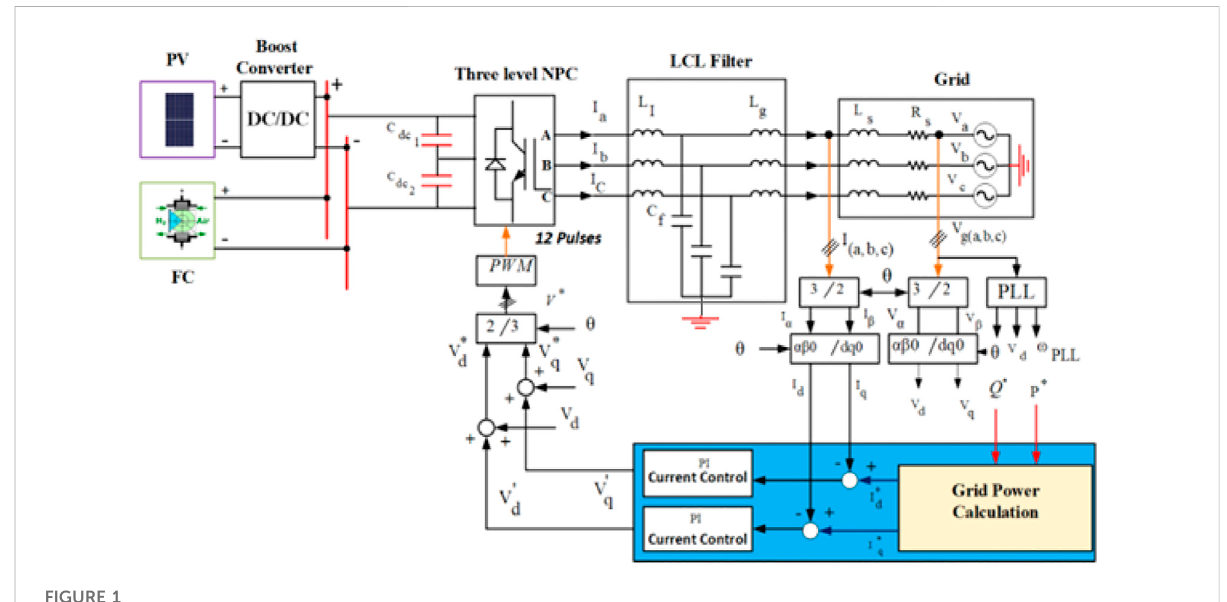
FIGURE 1 On-grid-hybrid PV- FC